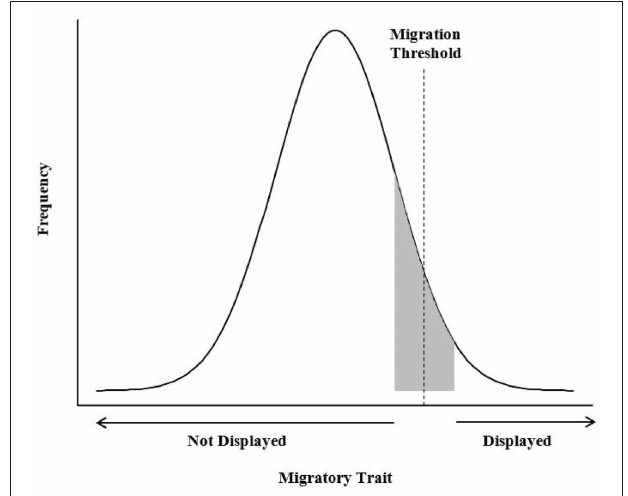
FIGURE 1 | The environmental-genetic threshold model assumes that a dichotomous trait is displayed as a result of an underlying continuous character or liability (i.e., migratory tendency) that is normally distributed within a population (Pulido, 2011). The combined effects of genetic influences and environmental effects on the threshold position can push a facultative migrant (represented in gray), with a liability close to the threshold, to either migrate or remain resident, depending on the direction of the environmental